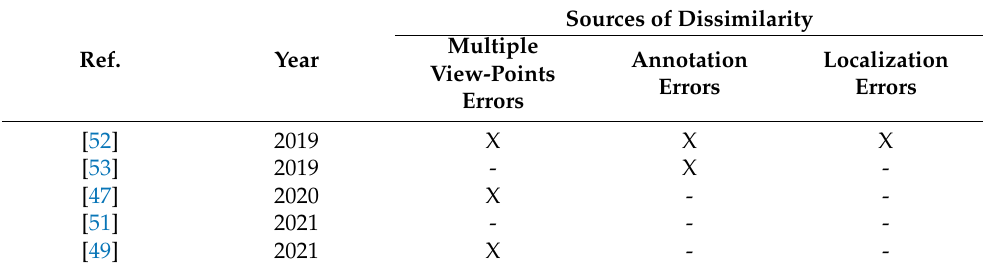
Table 3. Sources of dissimilarity addressed in the reviewed works in relation to the collaborative semantic-mapping